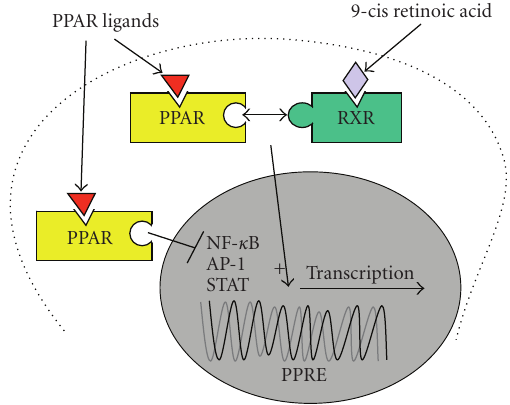
Figure 1: Transactivation and transrepression e ff ects of peroxisome proliferator-activated